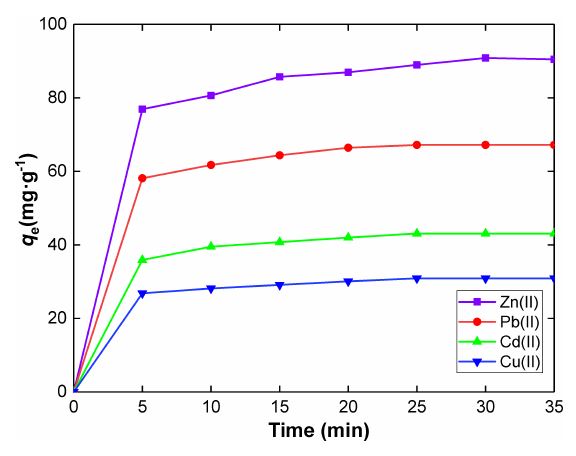
Figure 6: Effect of contact time on the adsorption capacity of Zn(II), Pb(II), Cd(II) and Cu(II) ions. Adsorption dose: V = 10 mL, m = 10 mg of SiNL at optimum concentration (100 ppm in each case), at pH 6 and 25 °C, ∆ q e = 0.3 (mg·g − 1